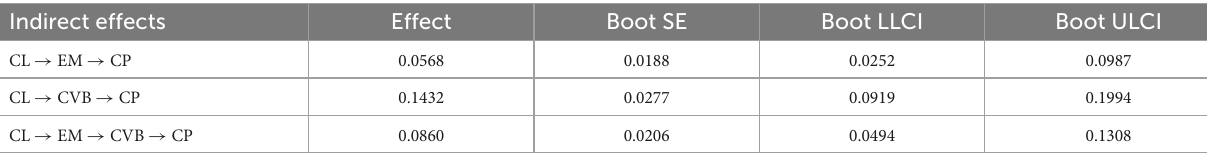
TABLE 4 Bootstrapped indirect